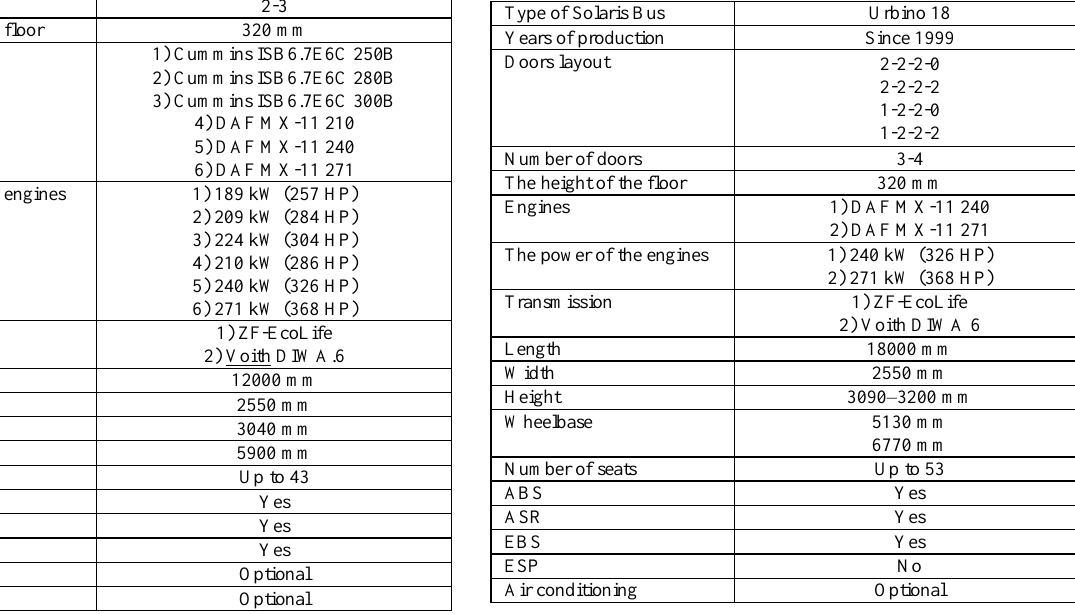
Fig. 3. Solaris Urbino 18 bus Table 3. Technical data of the Solaris Urbino 18 bus